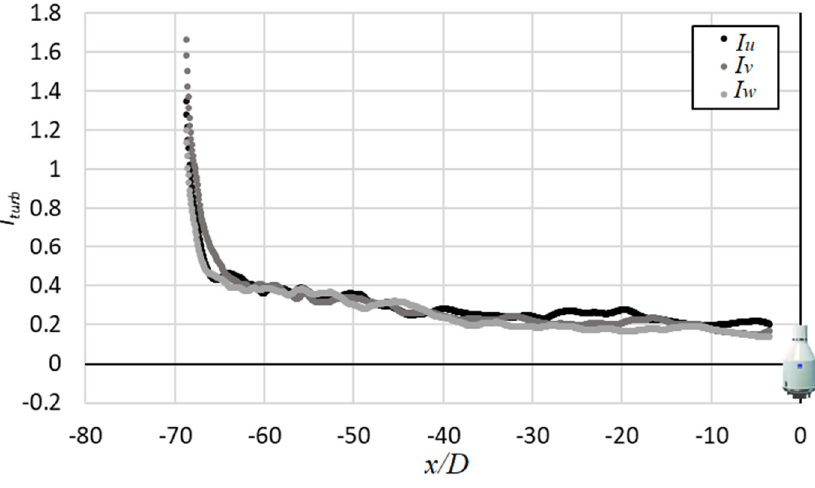
Figure 6. Decrease of the three numerical relative turbulence intensity profiles at the gauge collector elevation along the spatial domain between the position of the obstacles ( x/D = −70) and the gauge ( x/D = 0).